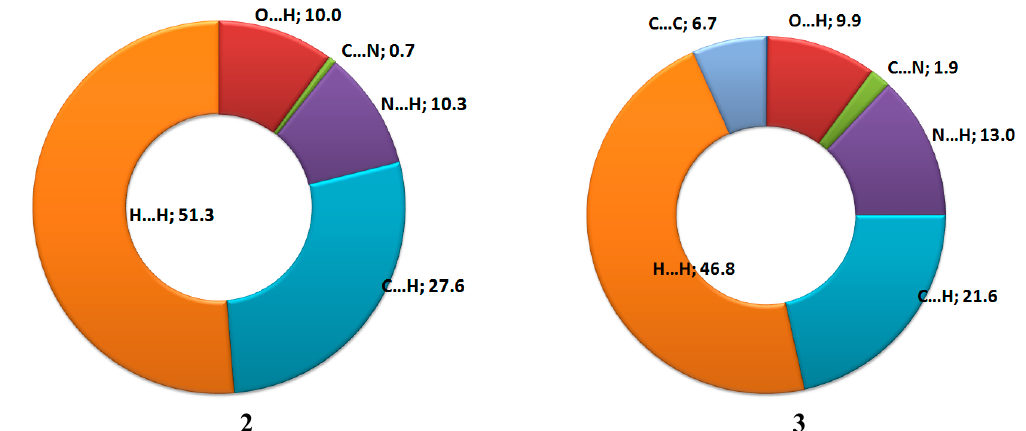
Figure 3. Different contacts and their percentage contributions in the studied compounds.